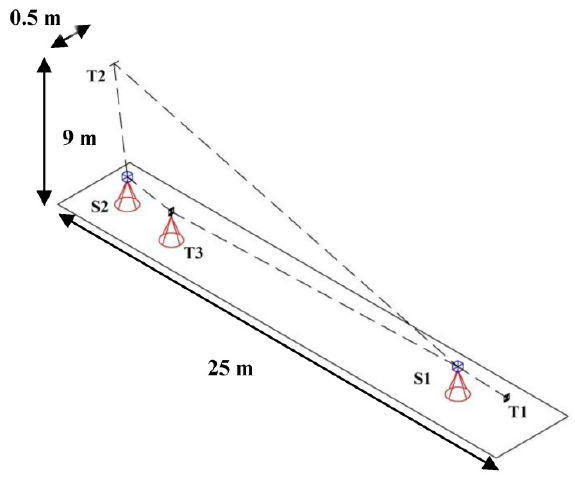
Figure 16. Minimal network configuration used in the simulation experiment: scanner stations (S1 and S2), targets (T1, T2, and T3).